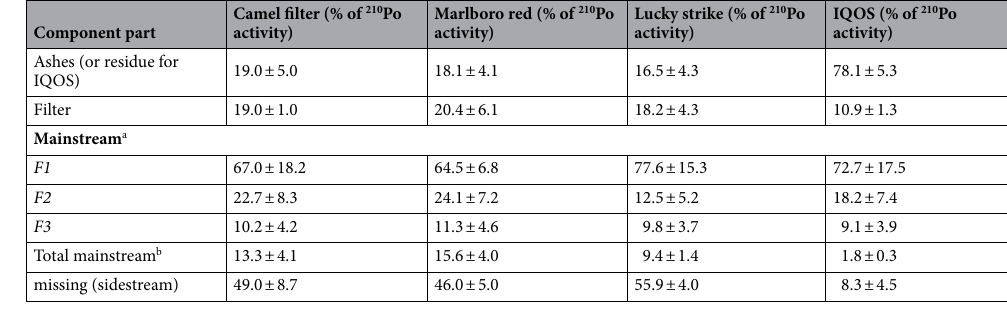
Table 2. Percentage (%) of the 210 Po activity measured in a given component part of tobacco products, namely ashes, filters, and mainstream smokes, compared to the total activity contained in the tobacco filler of cigarette. Average value of three experiments using five cigarettes smoked in each experiment. F1: washing flask 1 connected to the conventional cigarettes or to the IQOS Heets bronze label cigarettes; F2: washing flask 2 connected to F1 and F3; F3: washing flask 3 connected to F2 and the smoking machine. a) Percentage of the total mainstream activity as measured in each of the three washing flasks. b) Percentage of the mainstream activity compared to the total activity in the